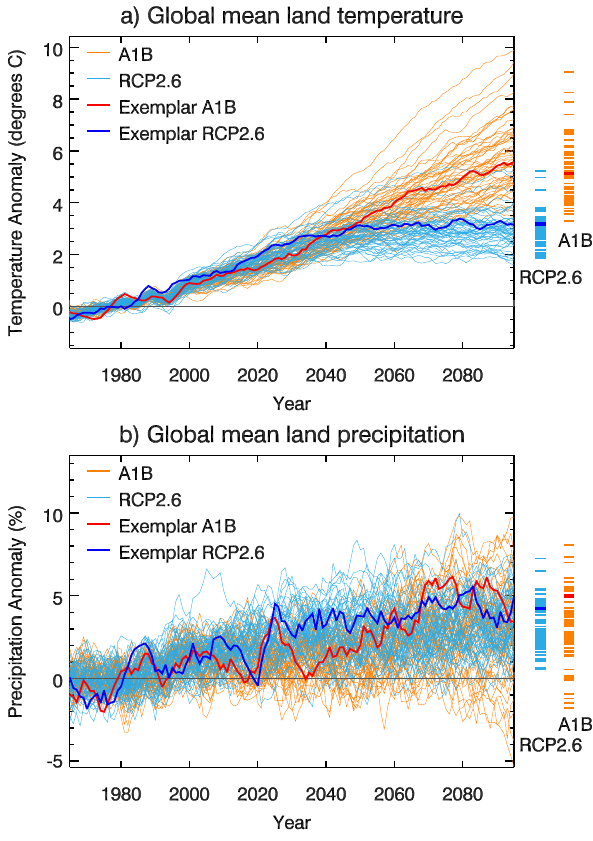
Fig. 3. Annual mean temperature (a) and percentage precipita- tion (b) anomalies (with 5yr smoothing) from 1961 to 2099 (rel- ative to the 1961 to 1990 average) averaged over land points, ex- cluding cold regions, for the ESE simulations. The A1B future sce- nario is shown in orange and RCP2.6 is shown in blue (individial lines represent individual models). The two exemplar simulations are shown in red (A1B) and dark blue (RCP2.6) respectively. The range of the ensemble is shown to the right of each plot, with the final 30yr average (2070–2099) for each ensemble member shown for each future